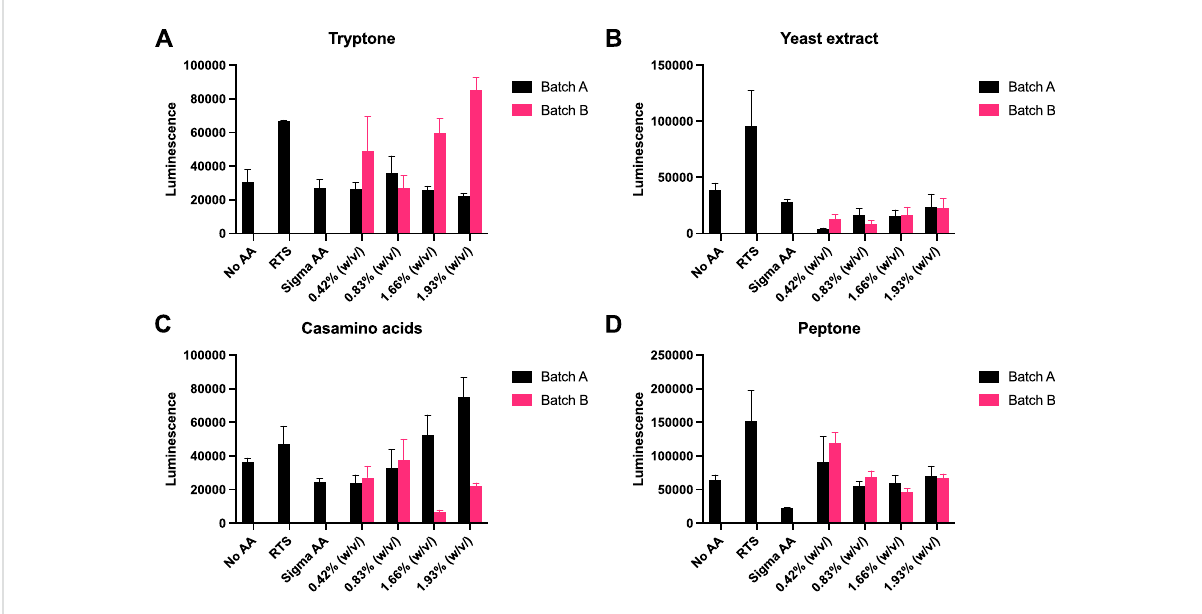
FIGURE 4 P. pastoris CFE with AA substitutes. (A) End-point luminescence measurements of P. pastoris CFE with (A) tryptone, (B) yeast extract, (C) casamino acids and (D) peptone. Error bars represent standard deviation of three technical measurements. End-point samples were collected after 2 h of incubation at 30 °